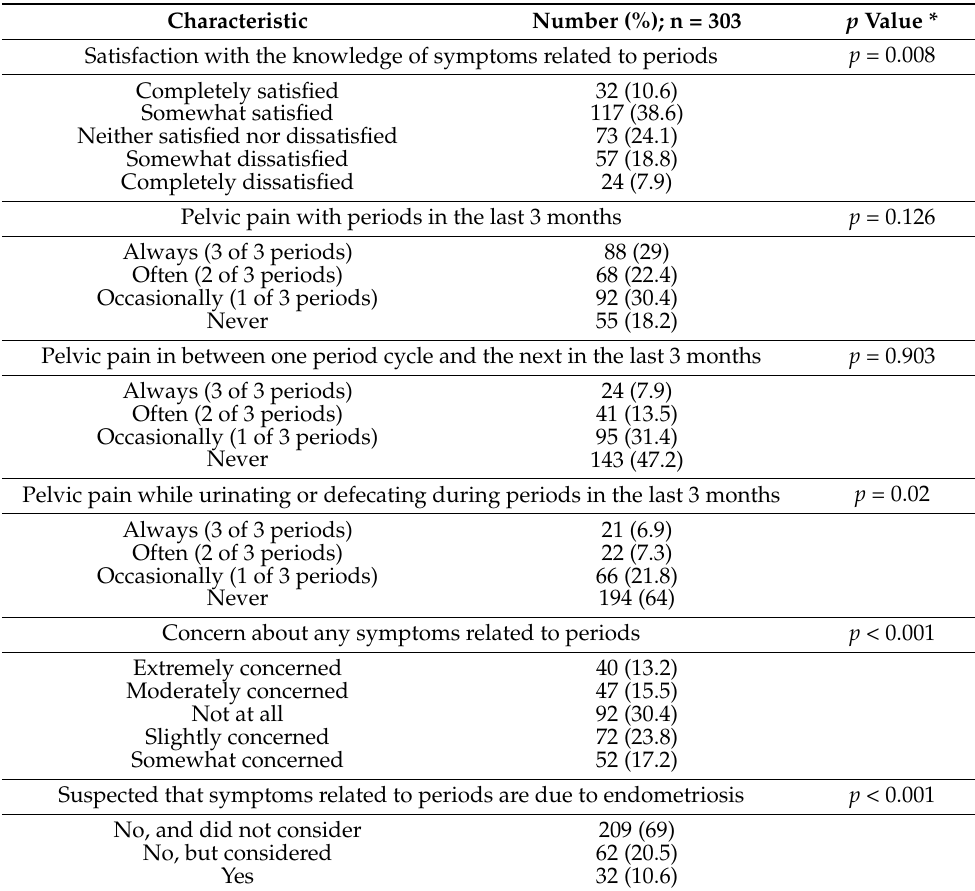
Figure 2. Participants’ responses to questions on endometriosis knowledge pre-and post-intervention. Table 3. Pre-intervention satisfaction with knowledge of symptoms, symptoms observed, and level of concern of the entire population ( n =